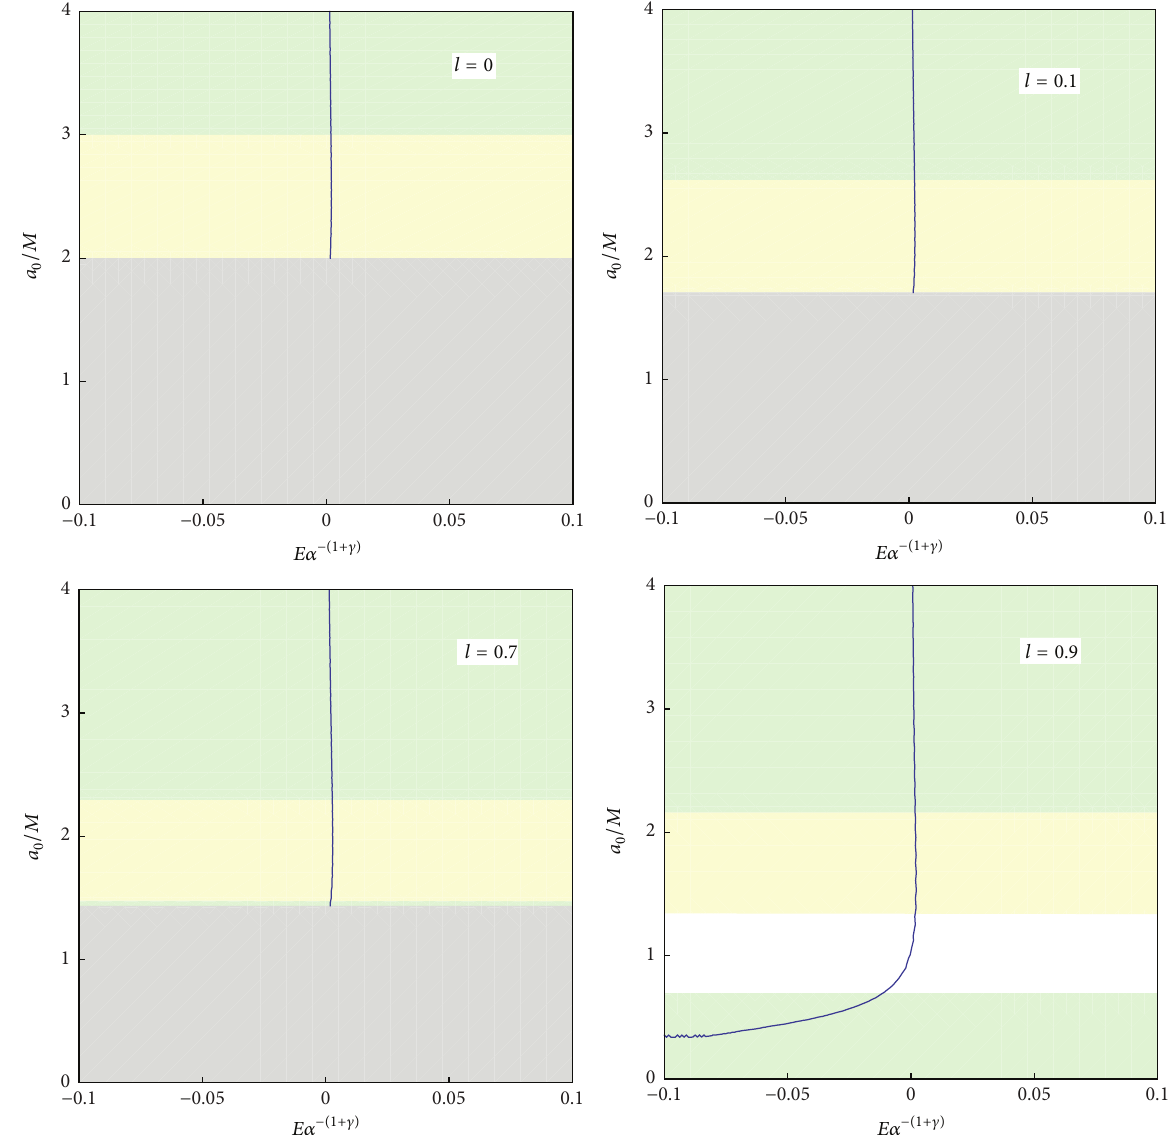
Figure 6: Plots for GCCG with 𝛾 = 1 , 𝑀 = 1 , 𝑤 = −10 , and different values of 𝑙